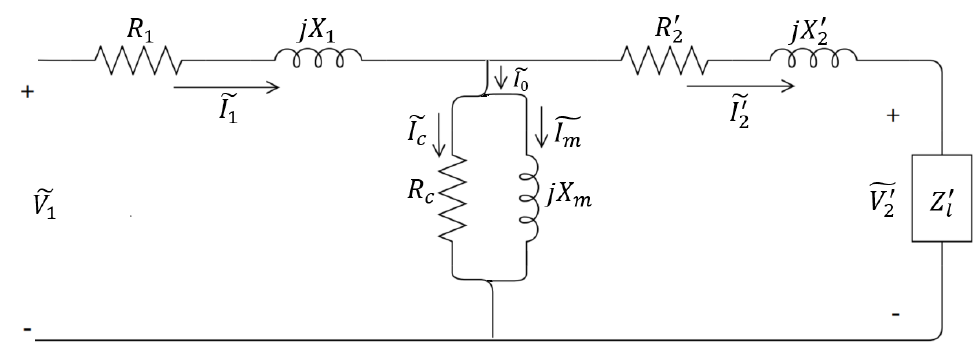
Figure 1. Single-phase transformer equivalent